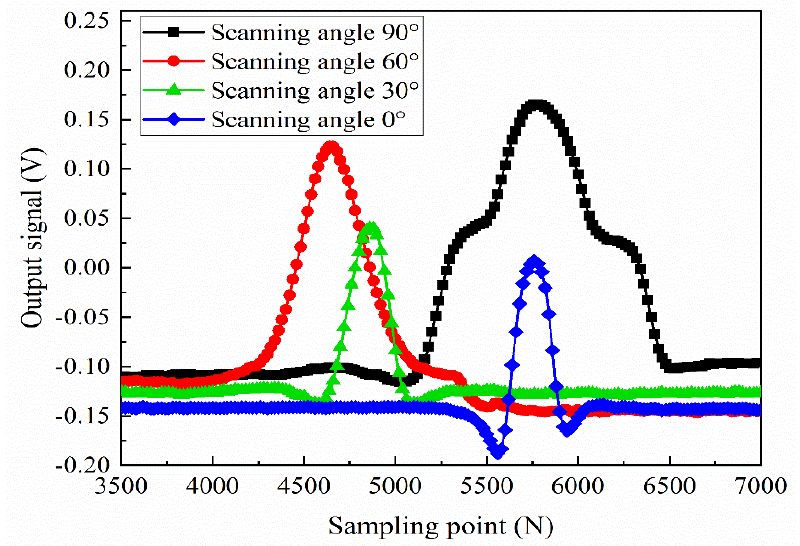
Figure 14. The crack defect signals of the dual-excitation UEC probe at different scanning angles.